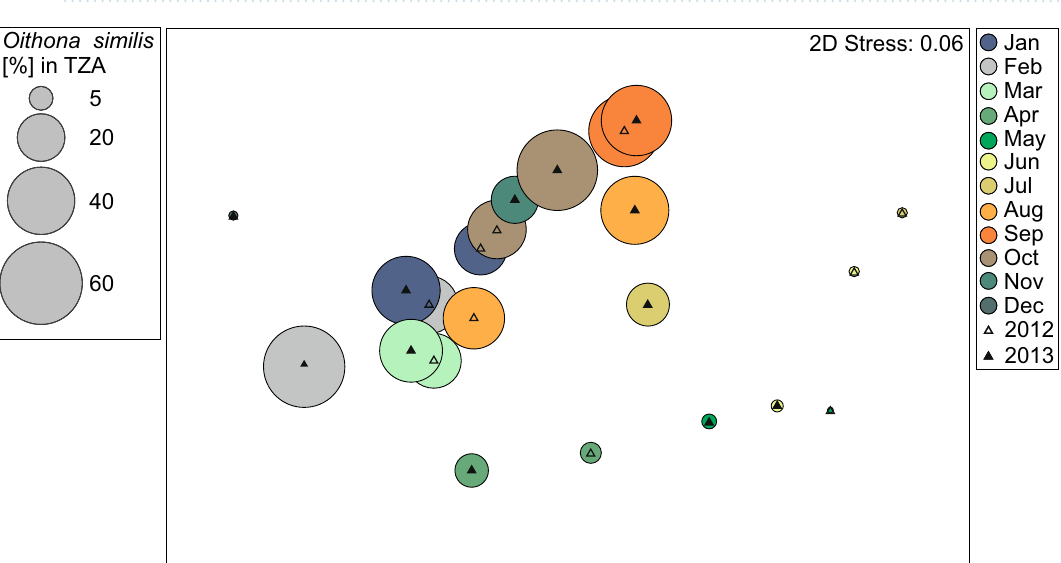
Figure 3. Percentage of the abundance of small copepods in comparison with other dominant groups (left graph) and share (%) of Microcalanus spp., Pseudocalanus spp. and Oithona similis to the small copepods (right graph) over 22 studied months in Adventfjorden.